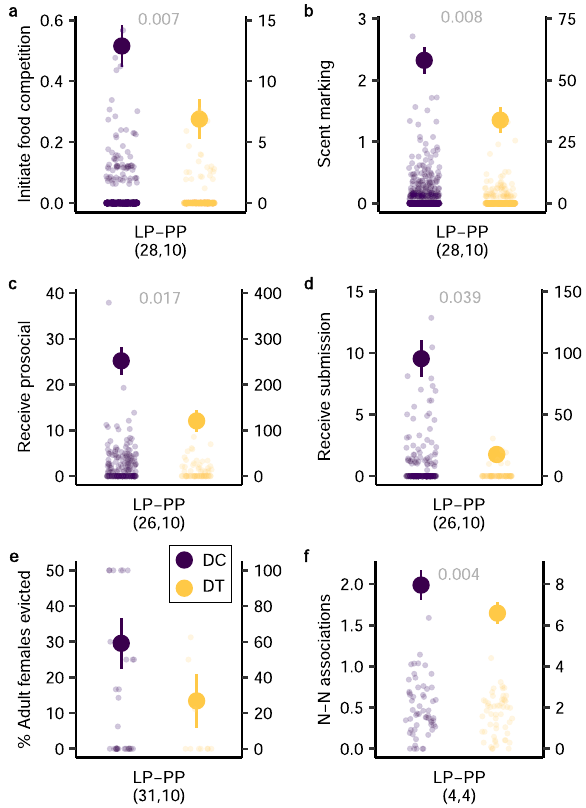
Fig. 3 Effects of antiandrogen treatment on the behaviour of dominant dams. Antiandrogen treatment of matriarchs during late-pregnancy (LP) and early postpartum (PP) reduces hourly rates of a initiating food competition, b scent marking, c receiving prosocial overtures and d receiving submissive acts relative to control matriarchs. Dominant control (DC, purple); dominant treated (DT, orange). Mean ± s.e. on the left y axis; raw data on the right y axis (to accommodate zero in fl ation). Analyses used GLMMs, with two-tailed χ 2 , based on 32 pregnancies of 22 dominant dams, observed during 1044 focal sessions. e The percentage of adult females evicted also appeared to be reduced in DT relative to DC dams, but analysis was precluded. Lastly, treatment reduced f hourly rates (scans/partner/hr) of dyadic nearest-neighbour (N-N) associations. For the LMM analysis, matriarchs were matched across control and treated conditions in four clans, with sample sizes ( n = 110) re fl ecting all possible adult dyads involving each matriarch, and a null expectation of no relationship between predictor terms and rate of proximity ( P values represent two-tailed tests). Accordingly, relative to DC dams, DT dams were in close proximity to another adult clan member during ~1 fewer scan/individual/2 h observation (in a clan with a mean of 14 adults, this value corresponds to a predicted difference of ~8 N-N associations/h). Values in parentheses represent the numbers of a – e pregnancies or f matched clans sampled; signi fi cant P values in grey. Source data are provided as a Source Data fi